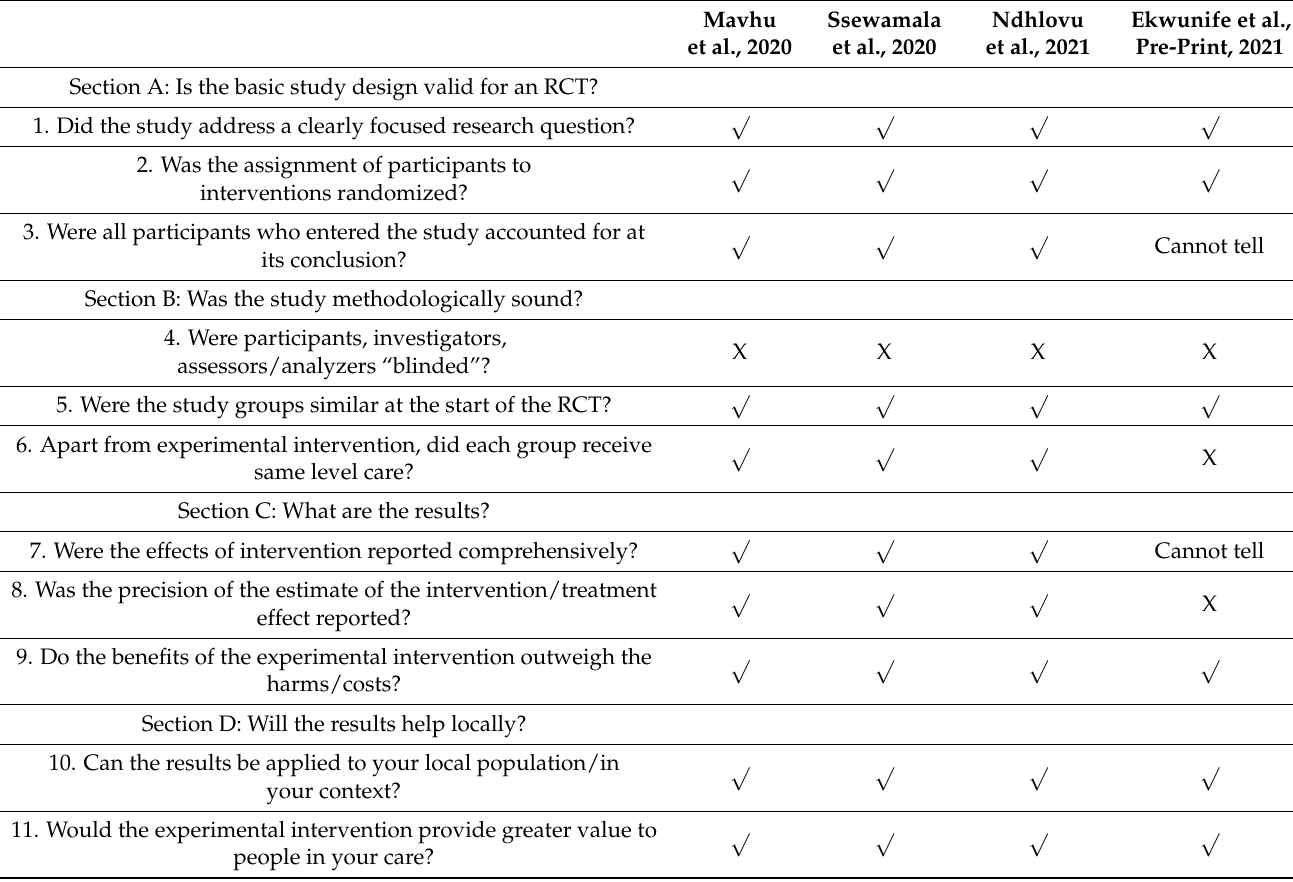
Table 3. Risk of Bias Assessment (Randomized trials using CASP tool).